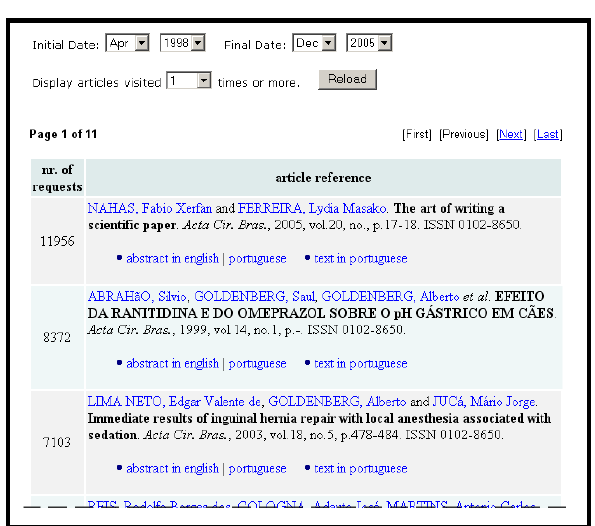
Acessos aos artigos